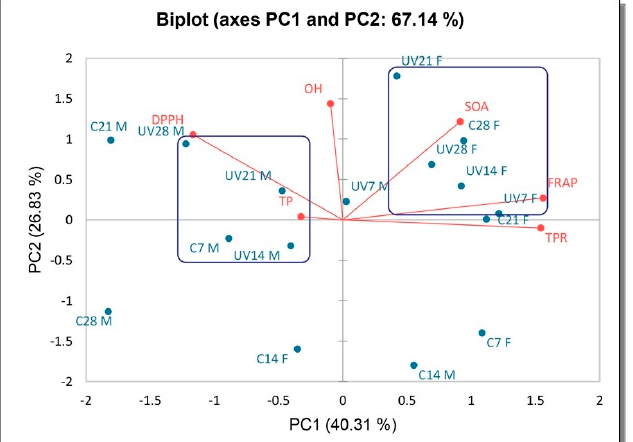
Figure 2. PCA of the AO properties and total contents of AO component of irradiated UV samples and control for T. versicolor . UV-samples exposed to UV irradiation, C-control, F-filtrate, M-mycelia biomass, 7, 14, 21, 28—days of incubation.